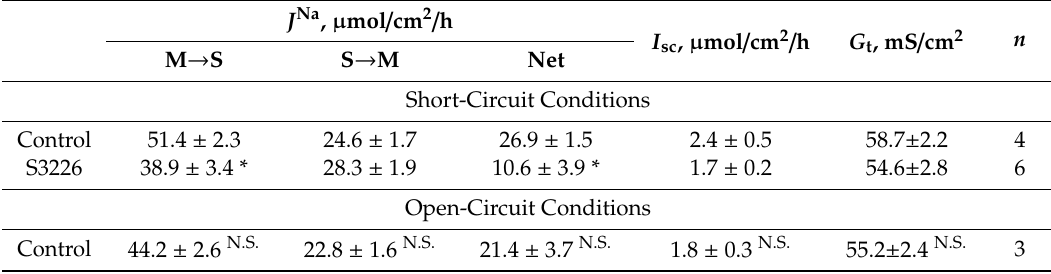
Table 1. Basal 22 Na + flux and electrical parameters in wild-type